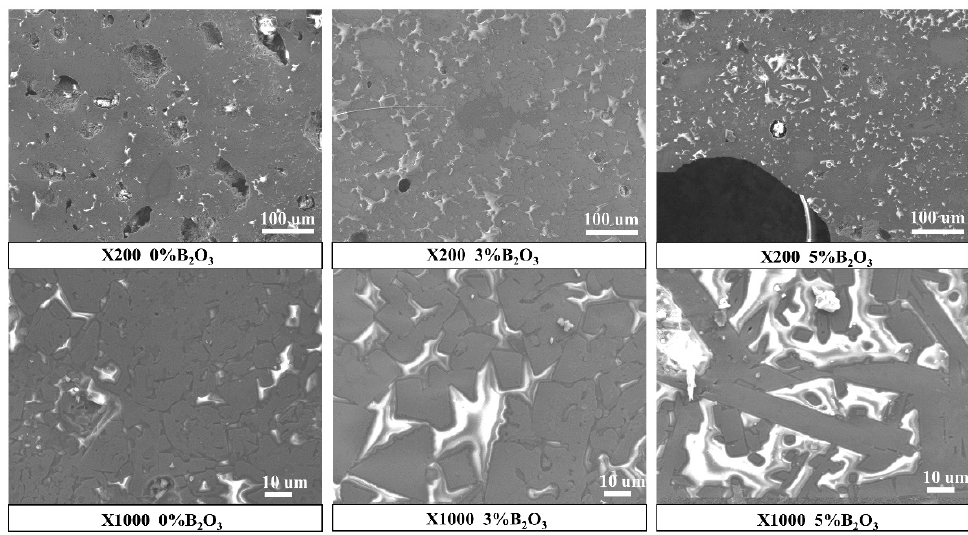
Figure 9. Scanning electron microscope (SEM) images of H-VTM at B 2 O 3 addition.